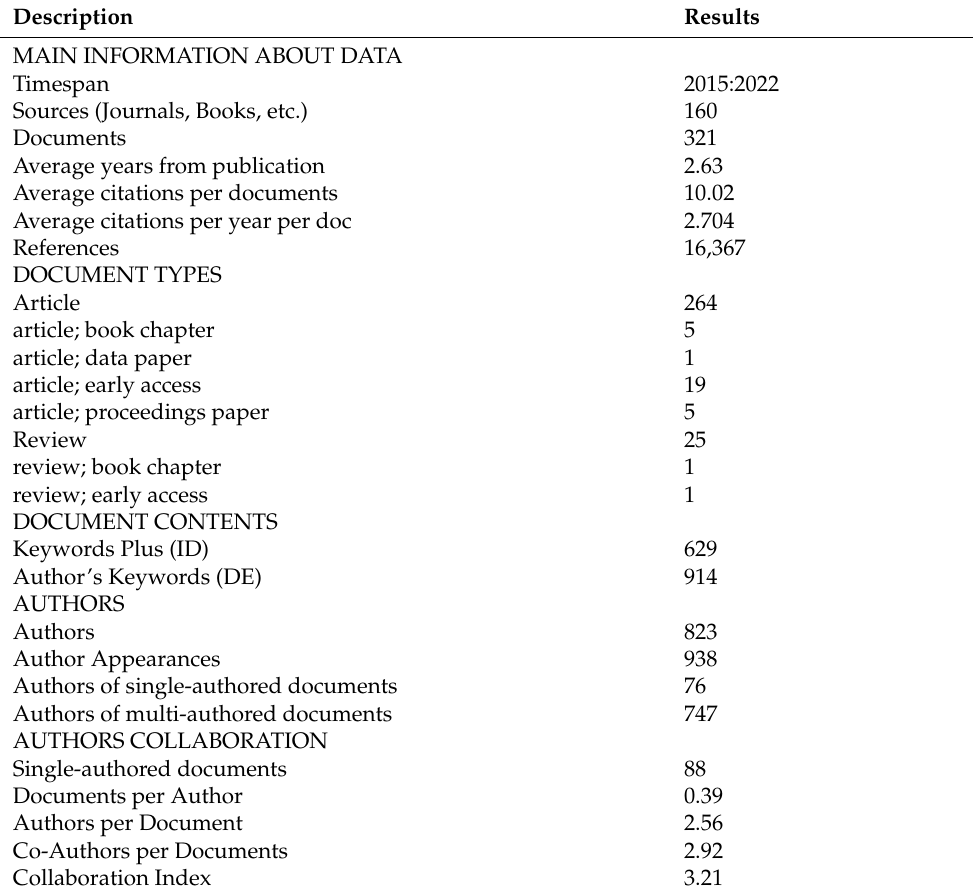
Table 1. General characteristics of